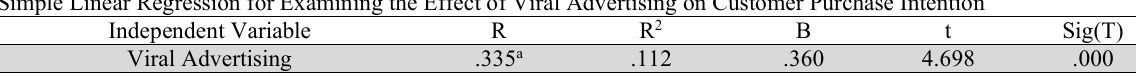
Multiple Linear Regression for Examining the Effect of Viral Marketing on Customer Purchase Intention Independent Variable R R 2 F Sig(F) B t Viral Advertising .368 a